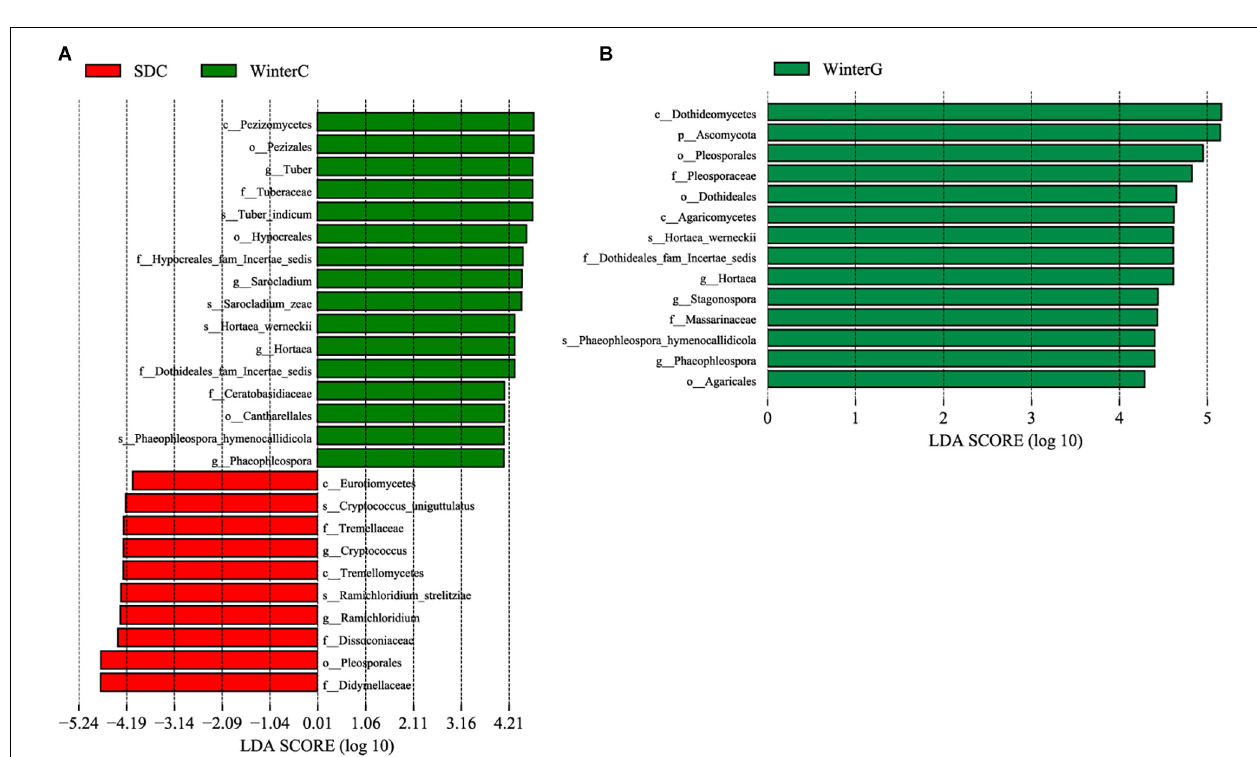
FIGURE 4 | Boxplots depict differences of alpha diversity between winter intestinal and hepatopancreas samples. WinterC, winter intestinal samples; WinterG, winter hepatopancreas. ∗ P < 0.05, ∗∗ P < 0.01.